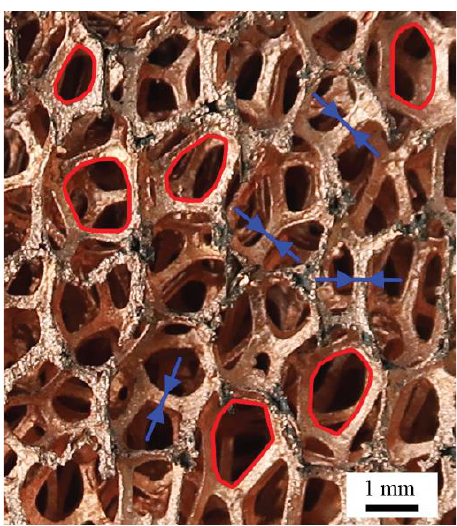
Figure 3. A sample selection of ligament diameter and individual pores, which are parallel to upper surface of sample.